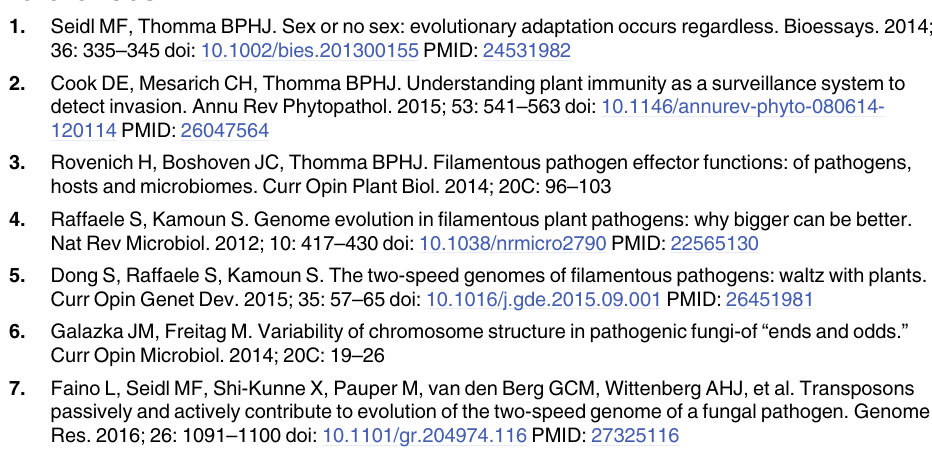
Fig 2. Impact of chromatin organization on adaptive (genome) evolution. (A) Genome rearrangements (red arrows) occur in open chromatin regions (euchromatin, green background;heterochromatin, red background) that are in spatial proximity within the nucleus. Chromosomes are shown as lines and genes as differentially shaped symbols. Spatial organization of the nucleus is highlightedby nuclear regions that are occupiedby distinct chromosomes(different colors). (B) Chromatin influencesgene expression, as genes located in open chromatin are transcribed (arrows), while genes located in heterochromatin are transcriptionally silent. (C) Interspecific genomehybridization leads to genome restructuring, often accompanied by extensive gene loss, and changes in transcriptional profiles, which can be influencedby differences in chromatin between parental species (genes from two parental lineagesare indicated by orange and blue, respectively). (D) Host jumps, specialization towards a specific host, and evasion of host immunity can be influencedby changes in chromatin that translate to alterationsin gene expressionor DNA